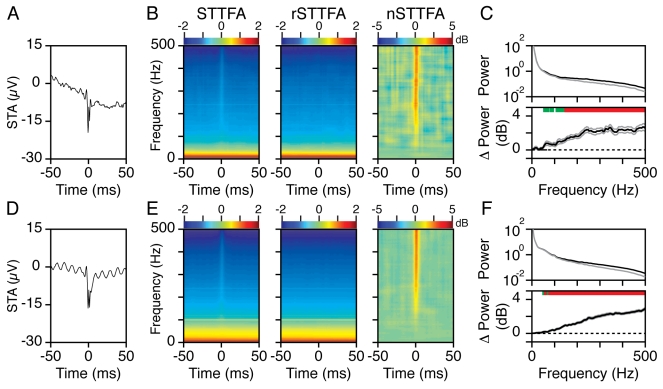
Spike-triggered average in time-frequency domain during baseline
period.(A) The mean spike-triggered average from spikes taken between 268 and
132 ms before stimulus onset, from the 14 sites for which at least 25
spikes were obtained. (B) Left panel shows the spike-triggered
time-frequency average (STTFA), computed by averaging short 2-D segments
of the time-frequency energy spectrum centered on the spikes. The middle
panel shows the STTFA computed after first randomizing the spike times
(called rSTTFA). The panel in the right shows the relative change in the
time-frequency spectrum locked to the spike, computed by taking the
difference between log(STTFA) and log(rSTTFA) (called the normalized
STTFA, or nSTTFA). (C) The mean energy between −1 to 3 ms of the
STTFA (black) and the rSTTFA (gray), as a function of frequency (upper
plot). The difference between the two is shown in the lower panel (mean
in black, SEM in gray). The values significantly different from zero are
shown in green (p<0.01, uncorrected) and red
(p<0.05 with Bonferroni correction). (D–F)
Same as (A–C), for 103 sites in Monkey 2.